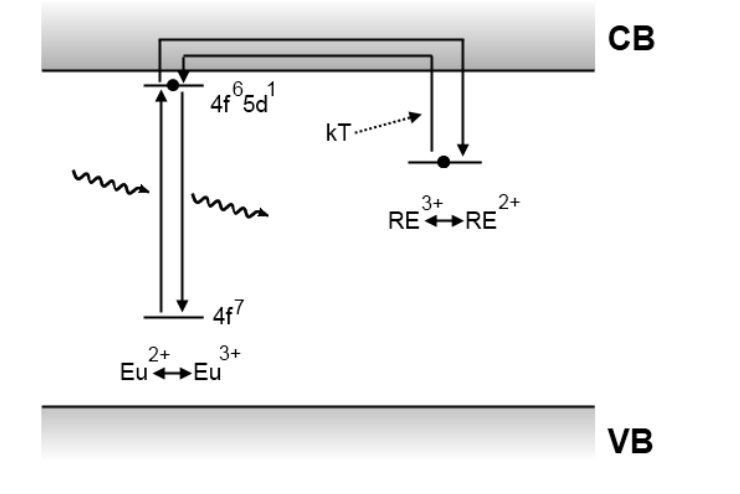
Figure 9. Persistent luminescence mechanism proposed by Dorenbos et al . for aluminate and silicate compounds